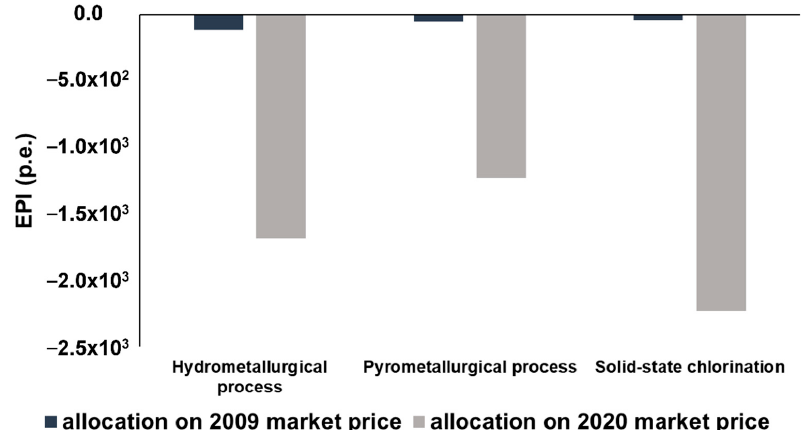
Figure 7. Comparison between the EPI resulting from the allocation on 2009 and 2020 REE oxide prices.